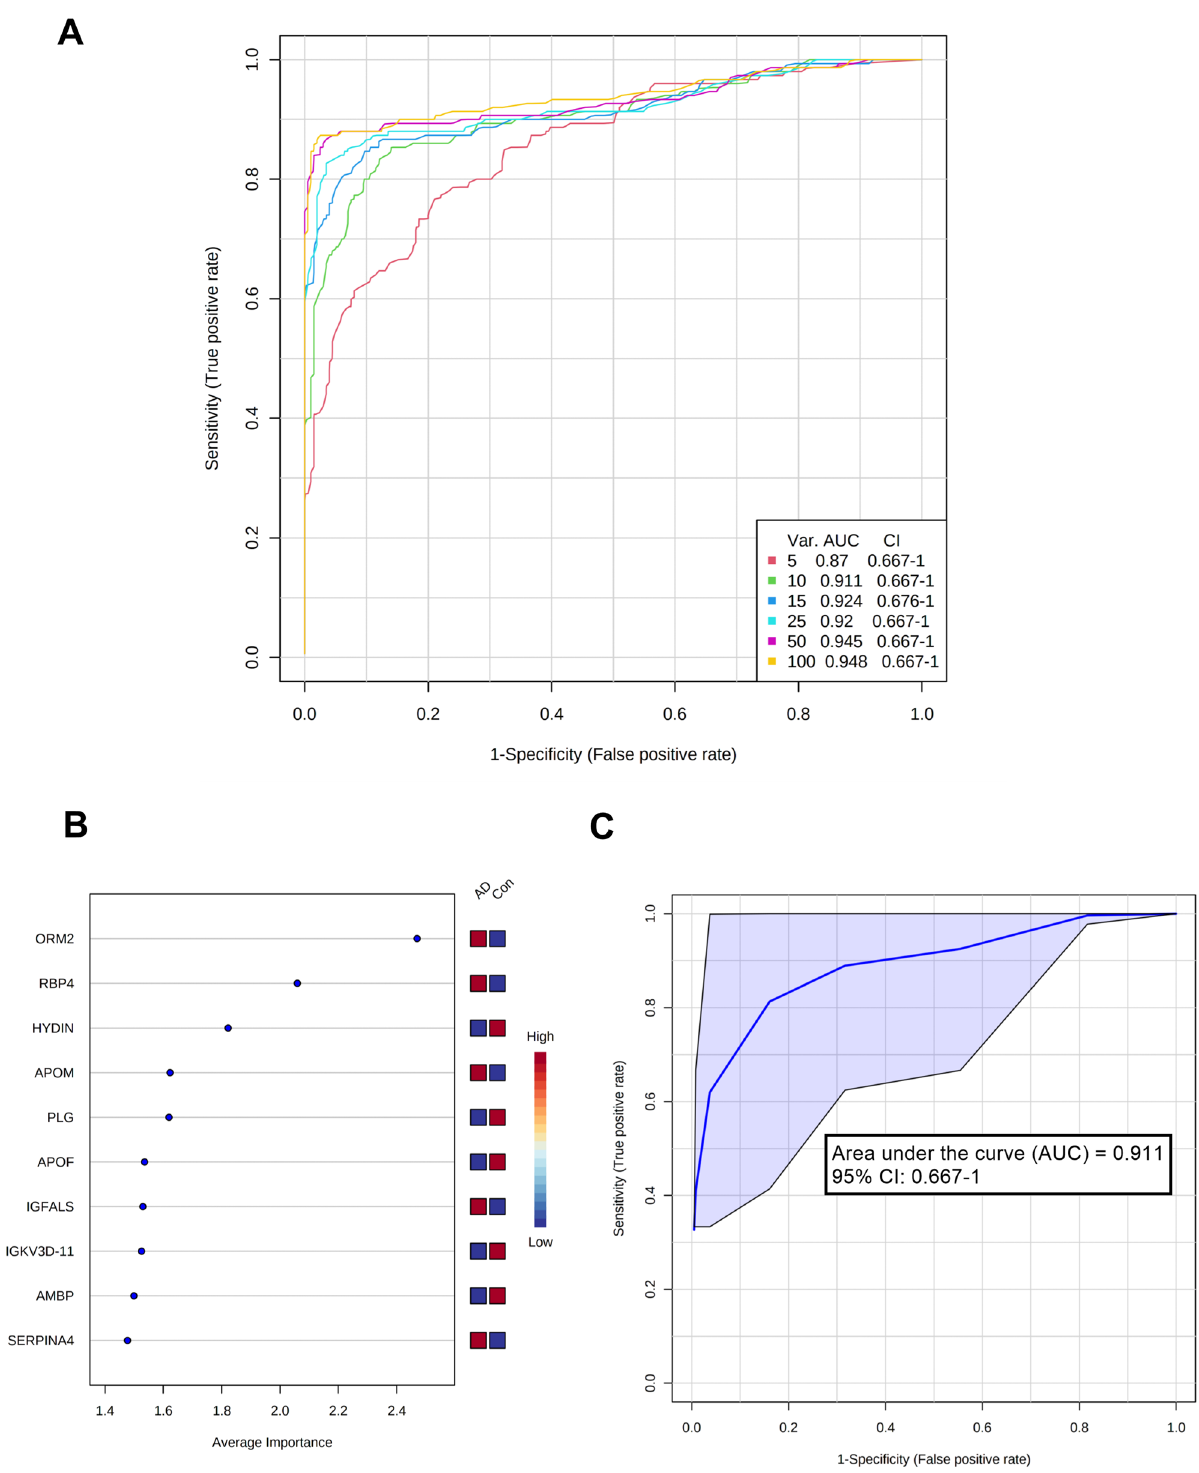
Figure 5. Random Forest analysis of important proteins for candidate biomarker models for AD diagnostics. ( A ) Receiver operating characteristic (ROC) curves of six models with increasing number of proteins (5, 10, 15, 25, 50, and 100 proteins). ( B ) Top 10 important features (proteins) based on average importance for model building. The intensity bar indicates the relevance of the specific protein for the AD or control group. ( C ) ROC curve for the model using the top 10 proteins to distinguish between cognitively affected and healthy